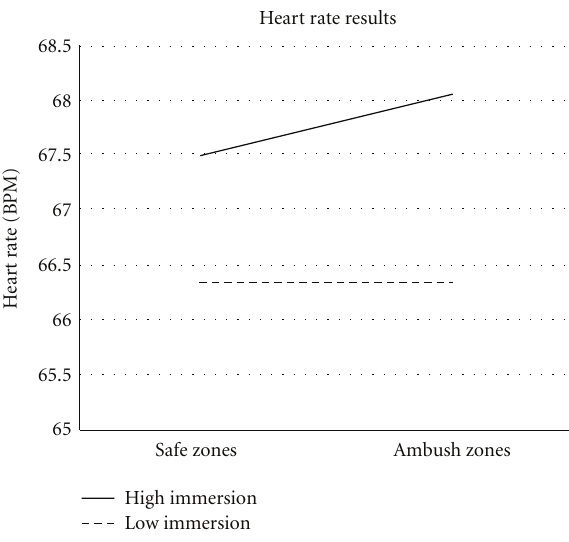
Figure 3: EMG eyeblink response amplitudes for high and low immersion conditions. All amplitudes are reported as T-scores. Figure 4: Heart rate responses (in beats per minute) for high and low immersion